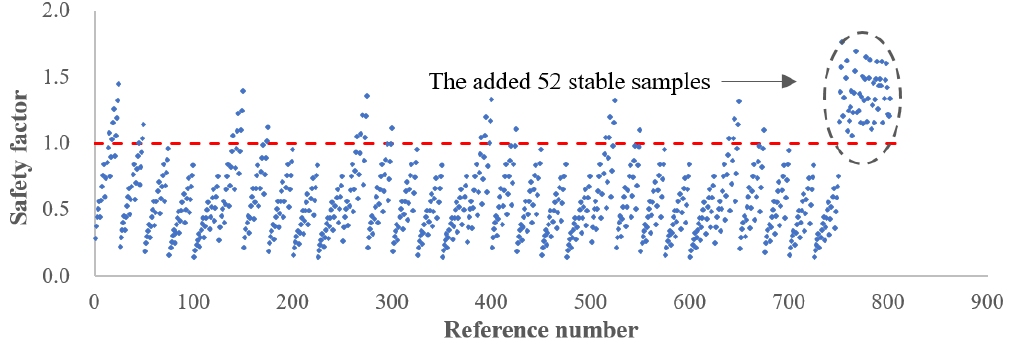
Figure 8. Strength reduction factors with additional samples.